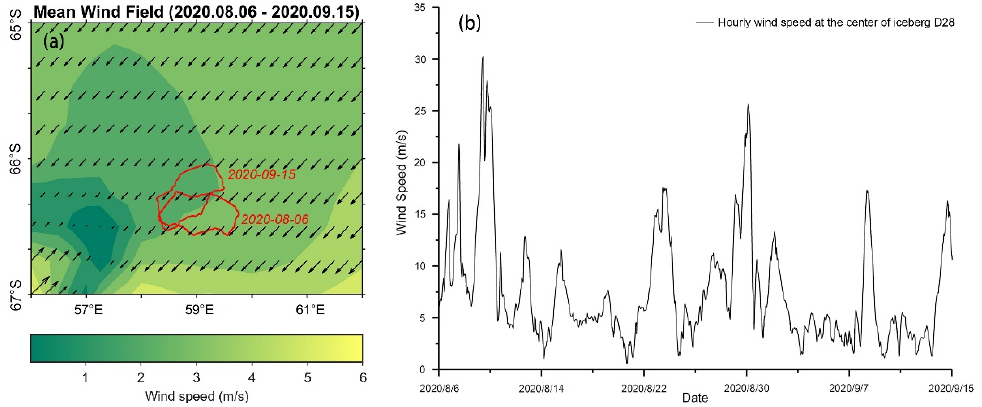
Figure 6. Wind field over the grounding area. ( a ) Mean wind velocity and ( b ) hourly wind speed trend at the center of iceberg D28 from 6 August to 15 September.